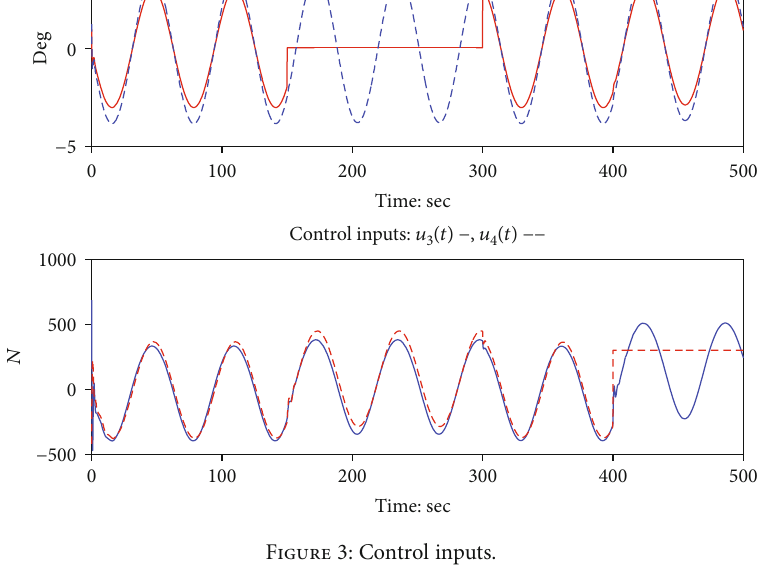
Figure 3: Control inputs.